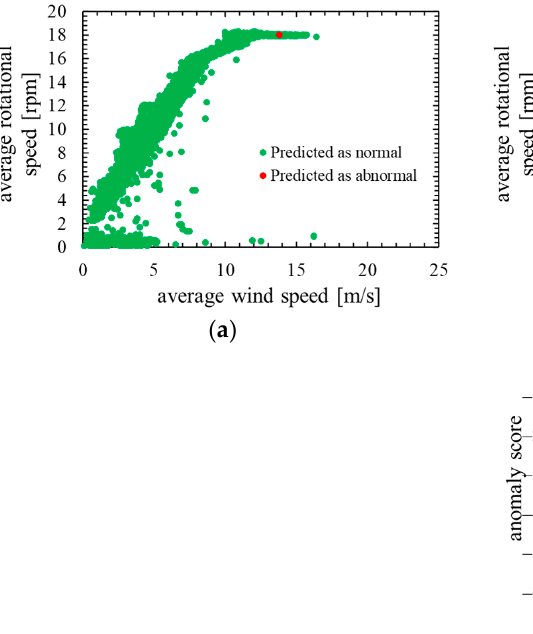
Figure 9. ROC curve of the model in which the number of mixture components K was 64 (the threshold is the 100th percentile’s value). Table 5 . Confusion matrix of the model in which the number of mixture components K was 64 (the threshold is the 100th percentile’s value).